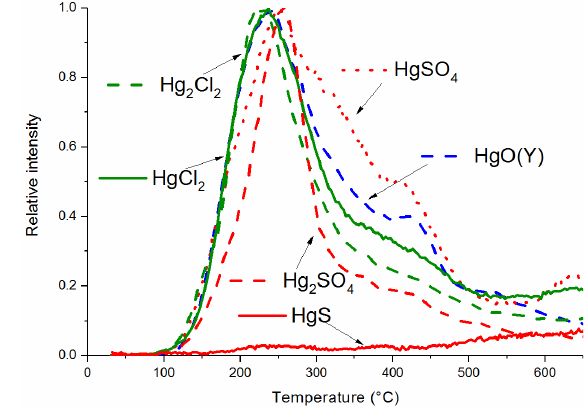
Figure 5: TPD spectra of mercury compounds prepared by dry mixing various Hg-species with pure CaSO